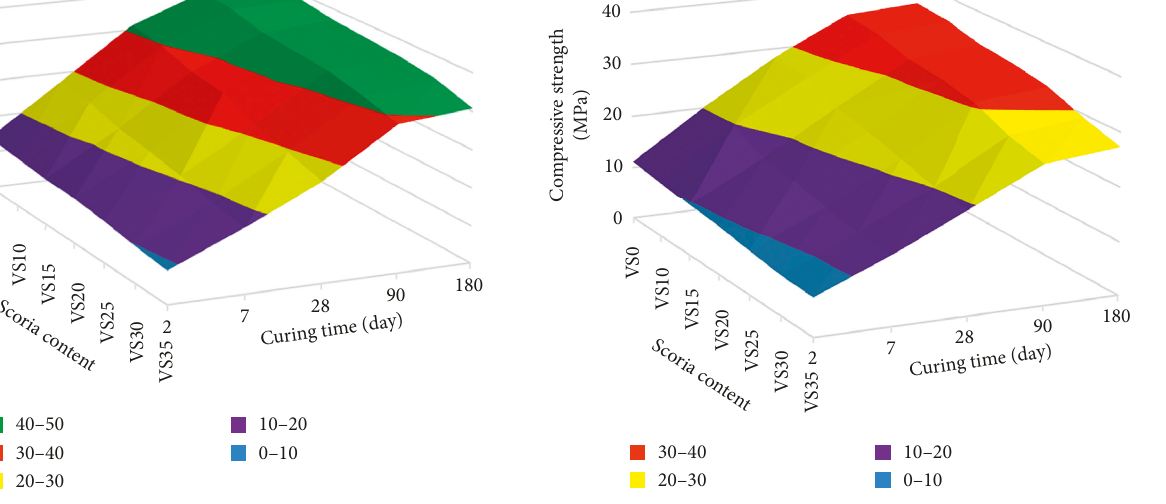
Figure 7: Development of compressive strength of VS-based binder concretes with curing ages at w/b � 0.5.